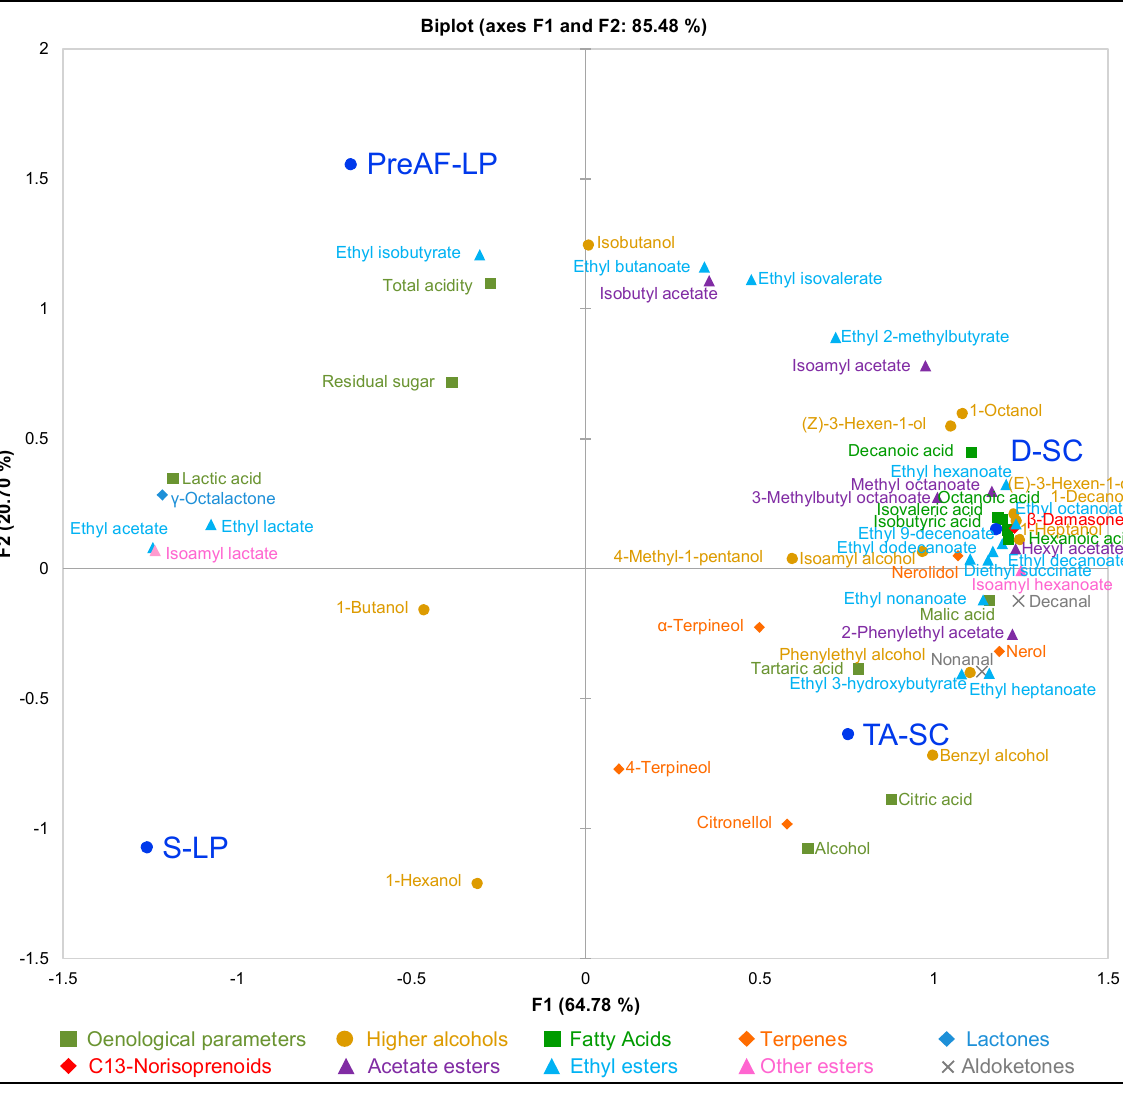
Figure 2. Principal component analysis of oenological parameters and volatile compounds in the Cabernet Sauvignon wines obtained from four different fermentation modalities.